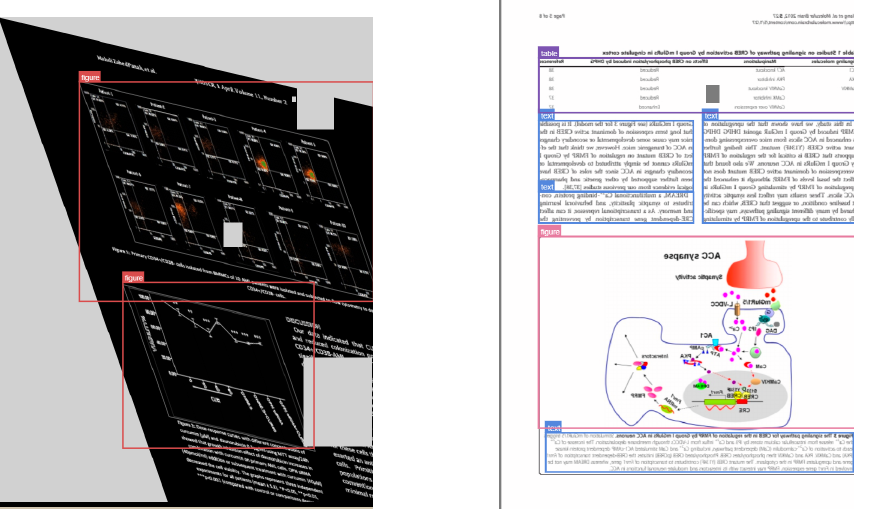
Figure 4. Left : Augmentation with scale, shift, and color change. Right : Augmentation with rotation. The images represent the classification pseudo boxes on two different augmented images. They are generated by the teacher model during the training process of the Soft Teacher model on 10% labeled